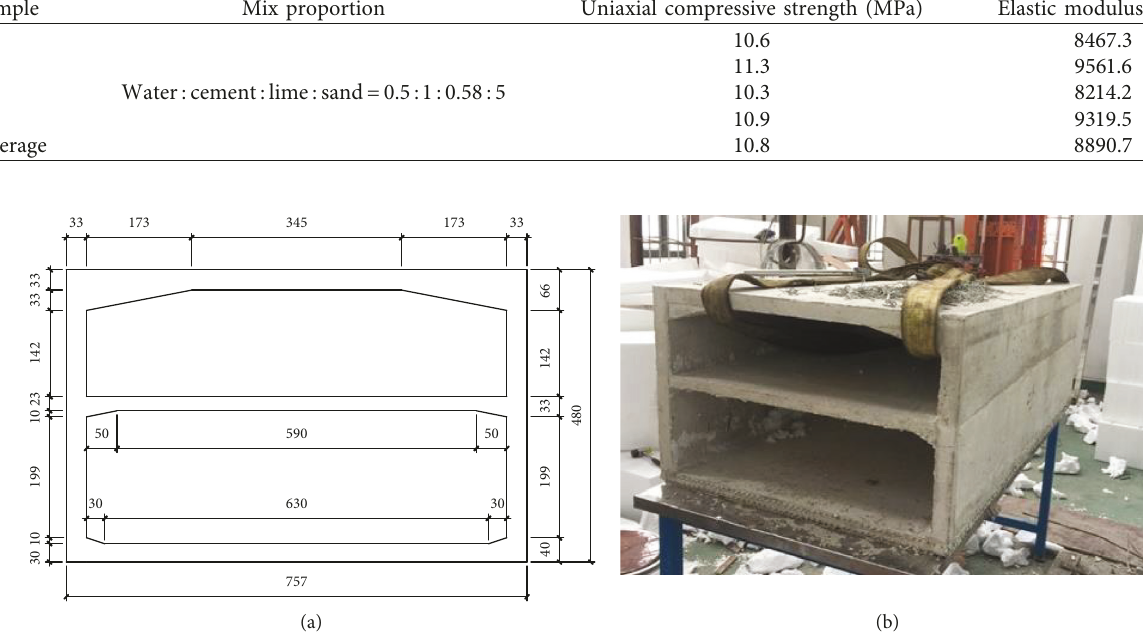
Table 2: Mix proportion and mechanical properties of the microconcrete.